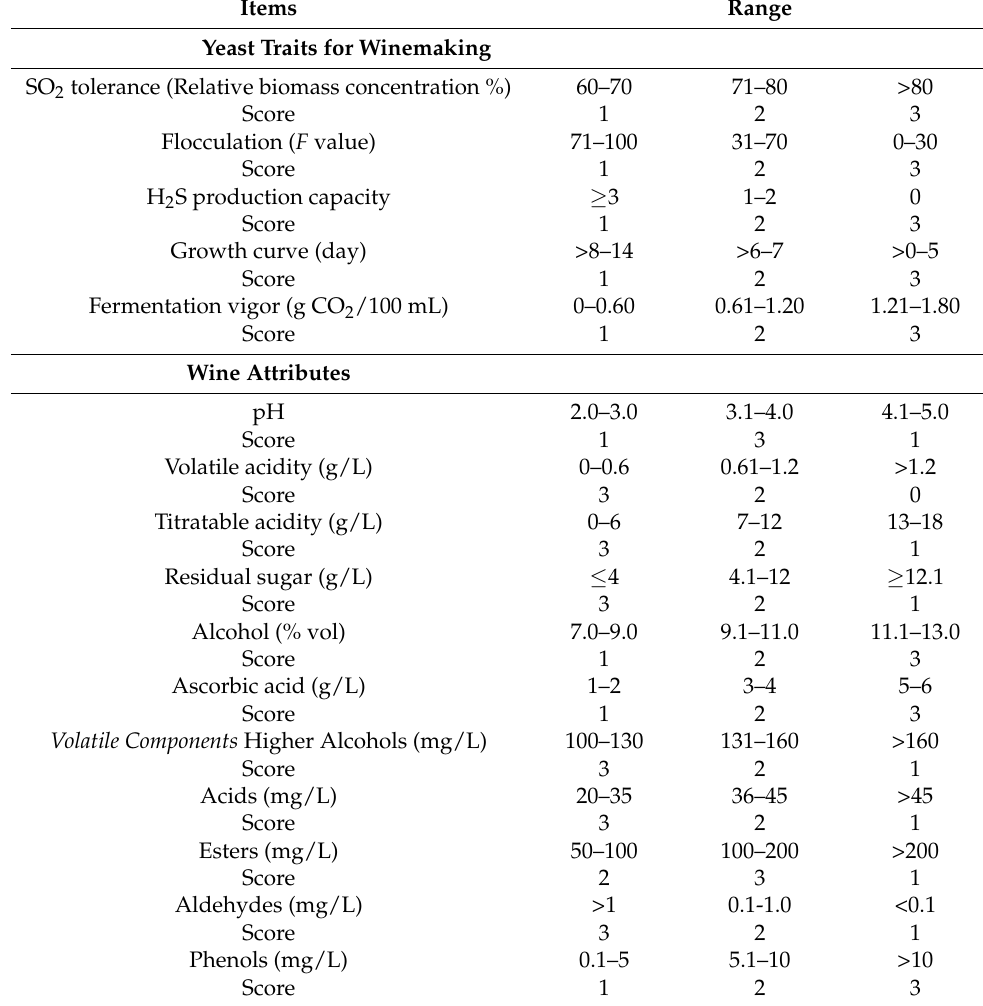
Table 3. Scoring standards for yeast traits for winemaking and the resultant wine attributes. Items Range Yeast Traits for Winemaking SO 2 tolerance (Relative biomass concentration